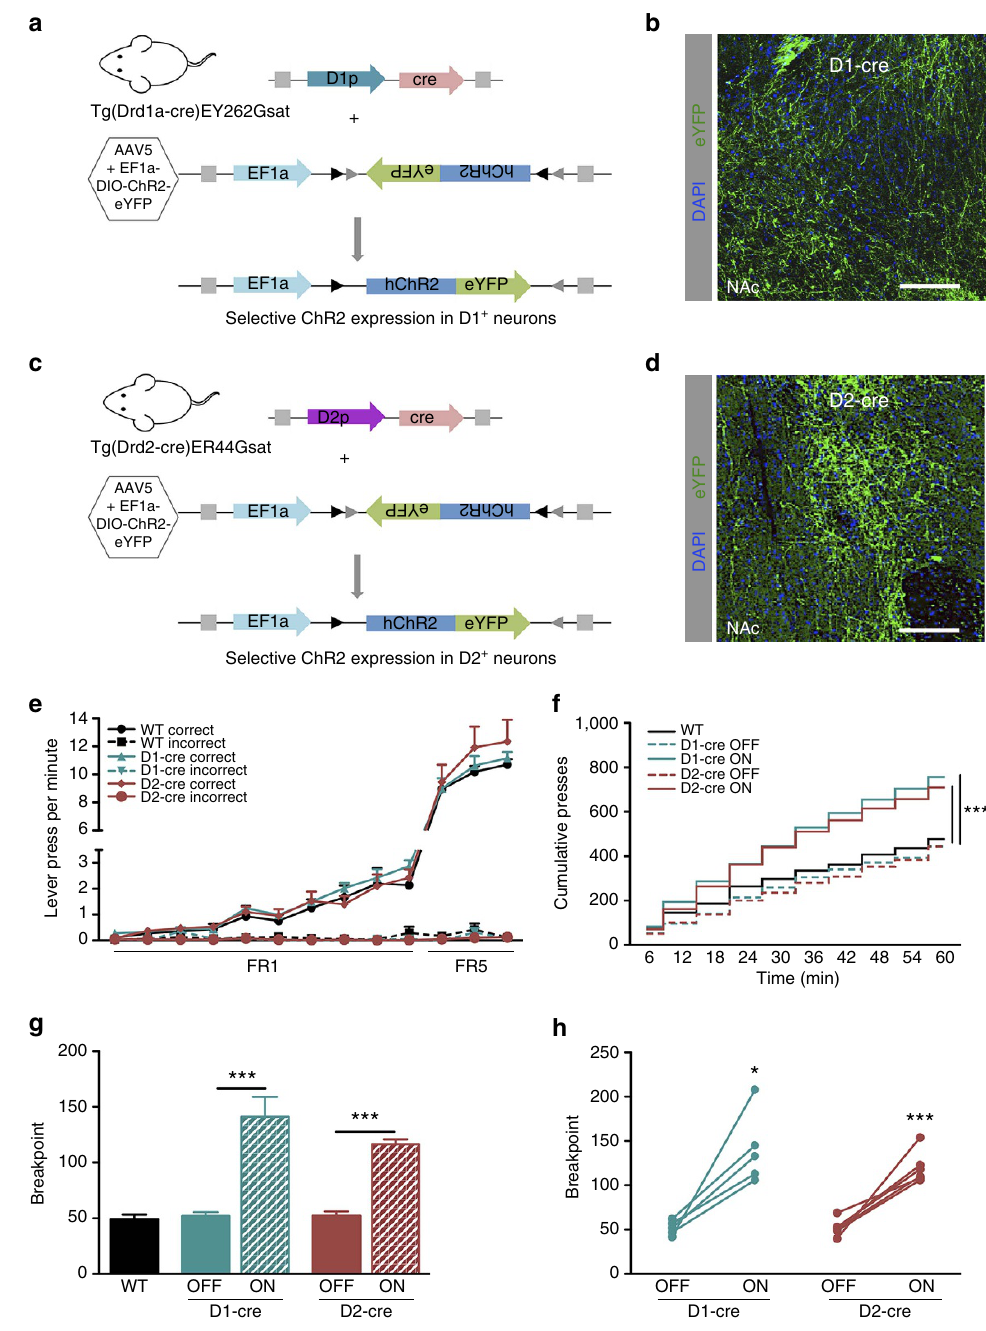
Figure 2 | Optogenetic activation of NAc D1 and D2 neurons enhances motivation in mice. ( a ) Strategy used for optogenetic activation of NAc D1 neurons in mice. A cre-dependent ChR2 construct (AAV5-EF1a-DIO-ChR2-eYFP) was injected unilaterally in the NAc of D1-cre transgenic mice (Tg(Drd1a- cre)EY262Gsat). ( b ) Expression of ChR2-eYFP in D1-cre animals; Scale bar: 50 m m. ( c ) Strategy used for optogenetic activation of NAc D2 neurons in mice. A cre-dependent ChR2 construct (AAV5-EF1a-DIO-ChR2-eYFP) was injected unilaterally in the NAc of D2-cre transgenic mice (Tg(Drd2-cre)ER44Gsat). ( d ) Expression of ChR2-eYFP in D2-cre animals; scale bar: 50 m m. ( e ) No differences were found in the learning curves of PR test between groups (n D1- cre ¼ 5; n D2-cre ¼ 6). ( f ) Optogenetic activation of D1 or D2 neurons (12.5ms light pulses at 40Hz, during 1s of cue exposure) increased cumulative presses throughout session. ( g,h ) Optogenetic activation of NAc D1 or D2 neurons strongly enhanced breakpoint. Error bars denote s.e.m. * P r 0.05, *** P r